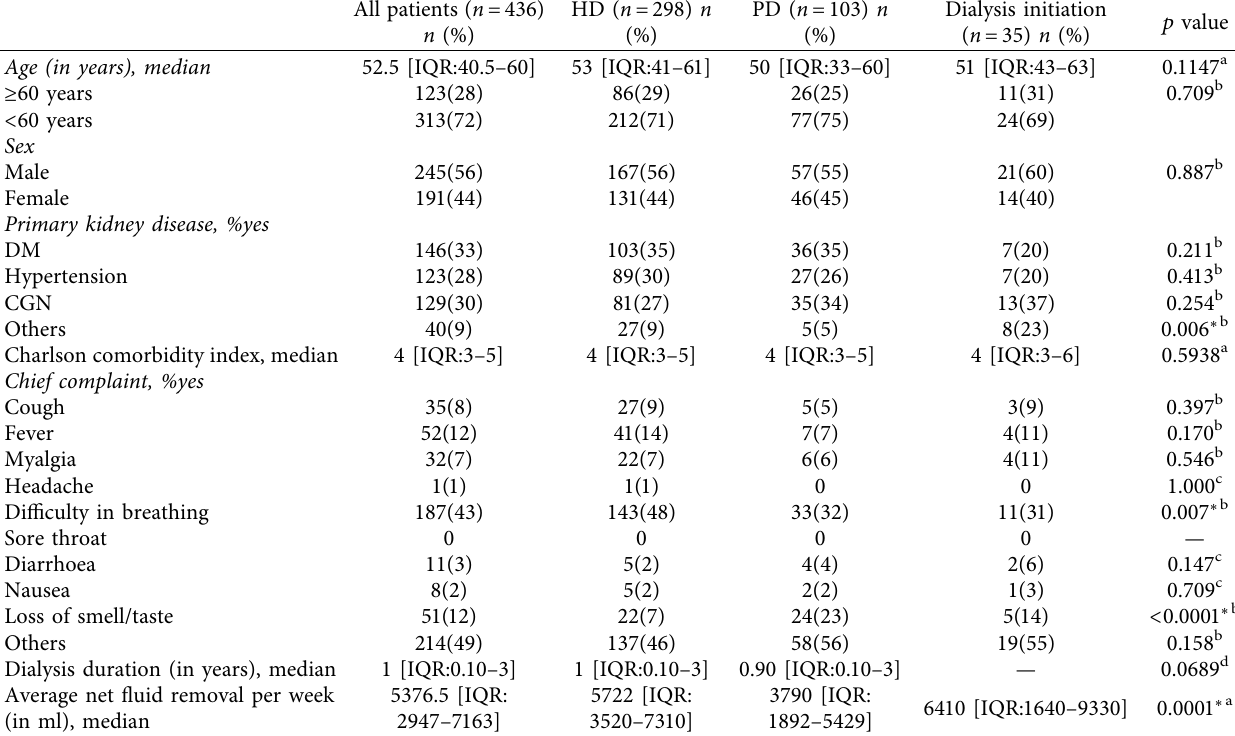
Table 1: Baseline characteristics of CKD V patients with COVID-19 ( n �